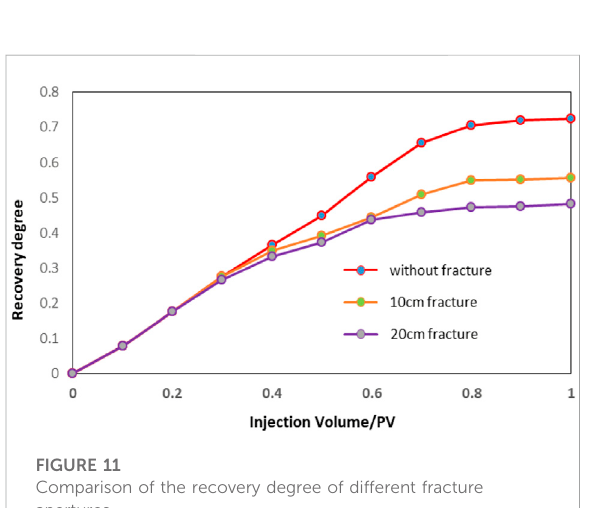
FIGURE 13 Main components of the gas phase at the moment when gas was detected.